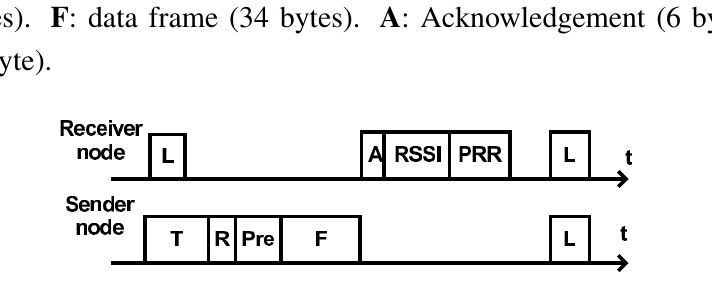
Figure 2 . RA-MAC. L : Polling (11 ms). T : Tone(12 ms). R : Data rate (1 byte). Pre